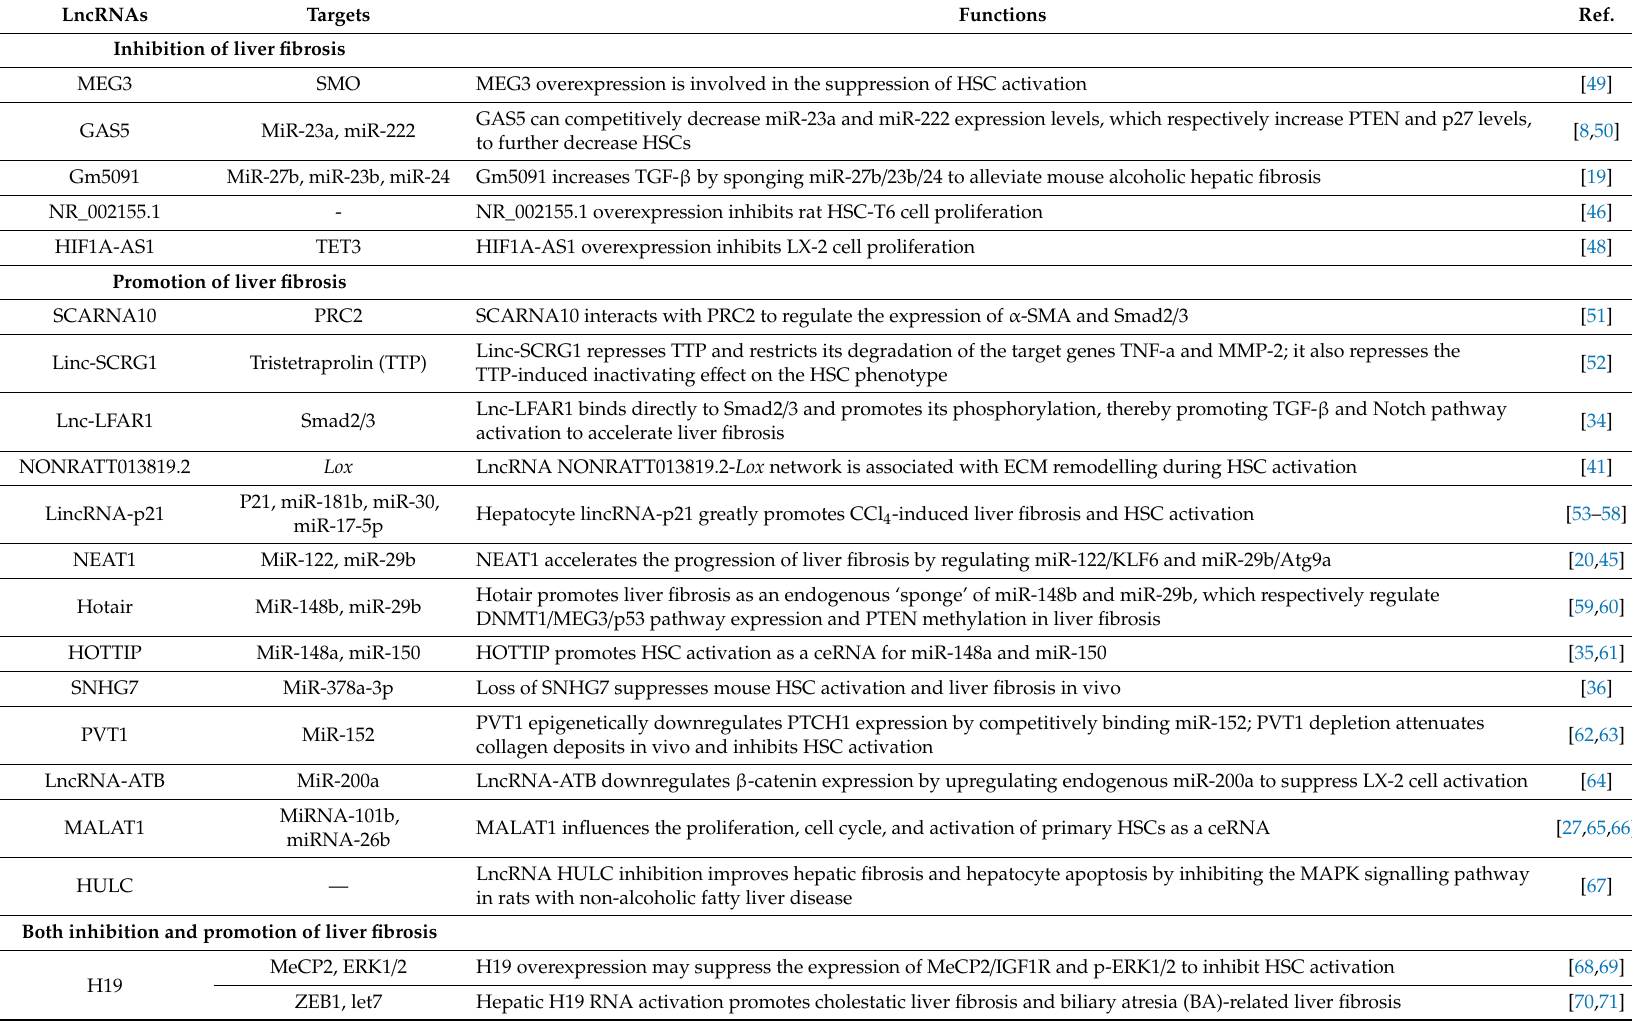
Table 1. LncRNAs are involved in regulating liver